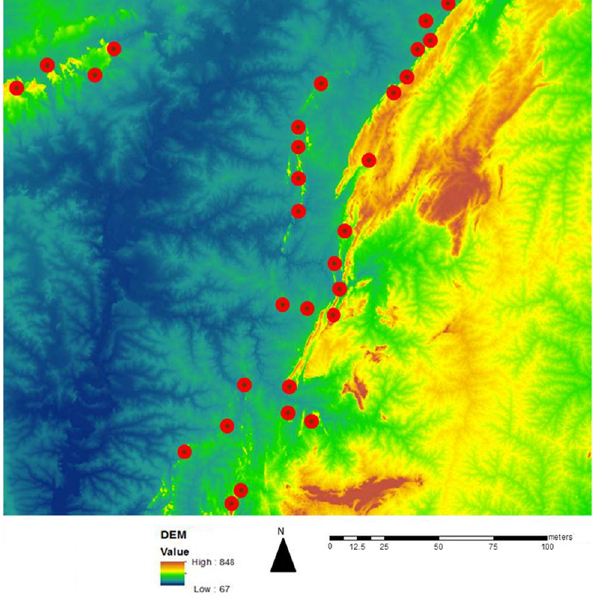
Figure 4. Comparison of habitats predicted by the wet rock and dry rock/elevation change models. Potential S. damnosum s.l. breeding habitats were predicted from images collected from the Sarakawa river basin using the BRR model (small black dots) or using a the model based upon the signature for wet or dry Precambrian rock and a sufficient elevation change to support fast flowing water if present (large red dots).